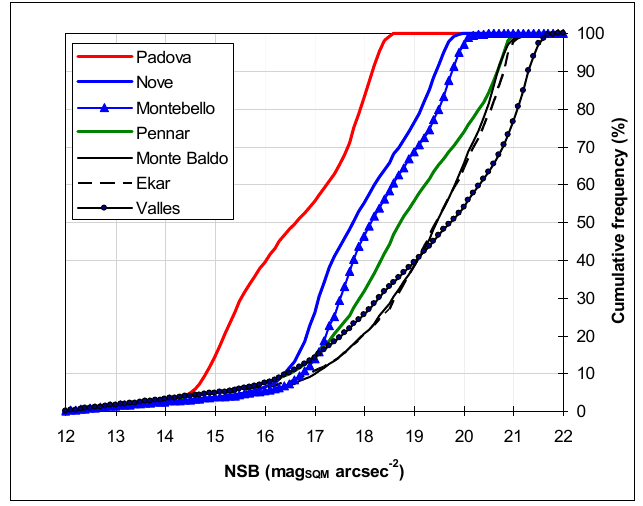
Figure 2. Cumulative frequencies of NSB in seven monitoring stations: red lines correspond to an urban station, blue to a suburban station, green to a rural station, and black to a mountain station.